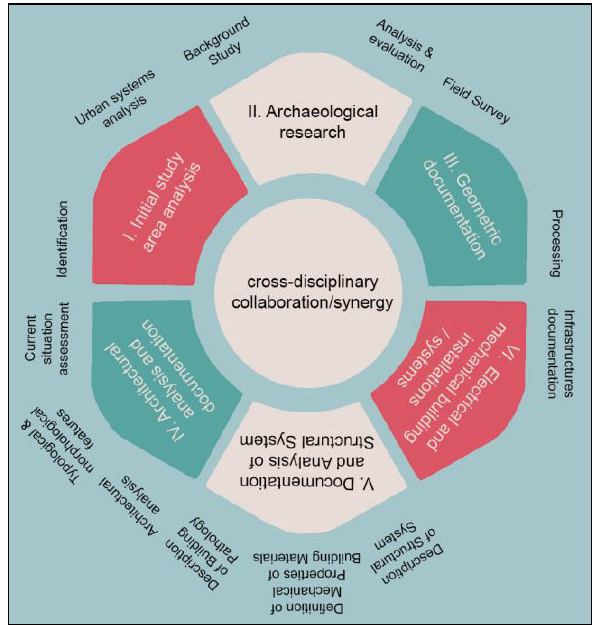
Figure 6 . Work stages of restoration study through documentation stage.